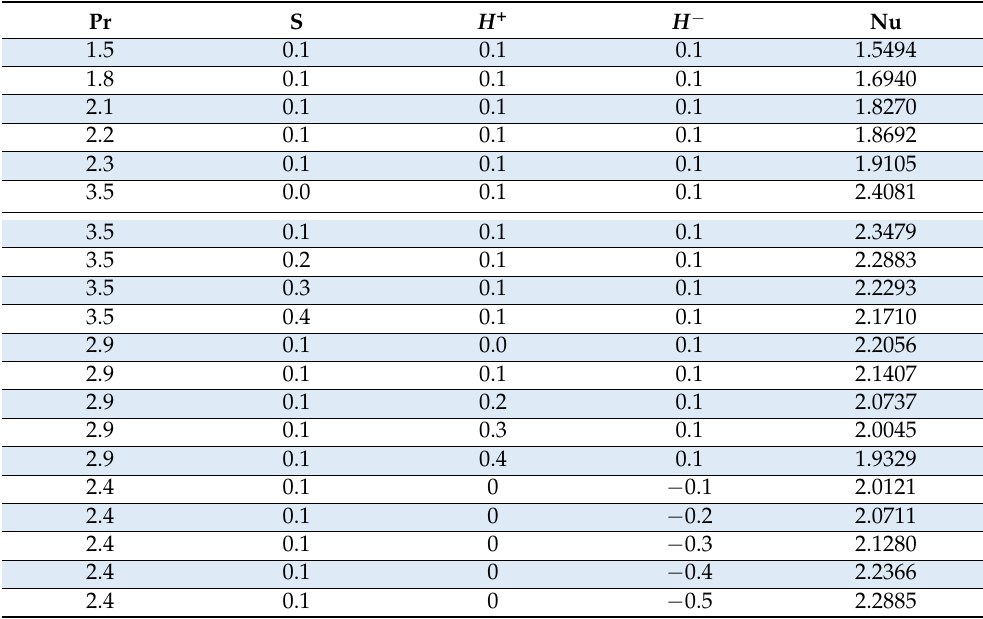
Table 3. Nusselt number variations subject to Flow